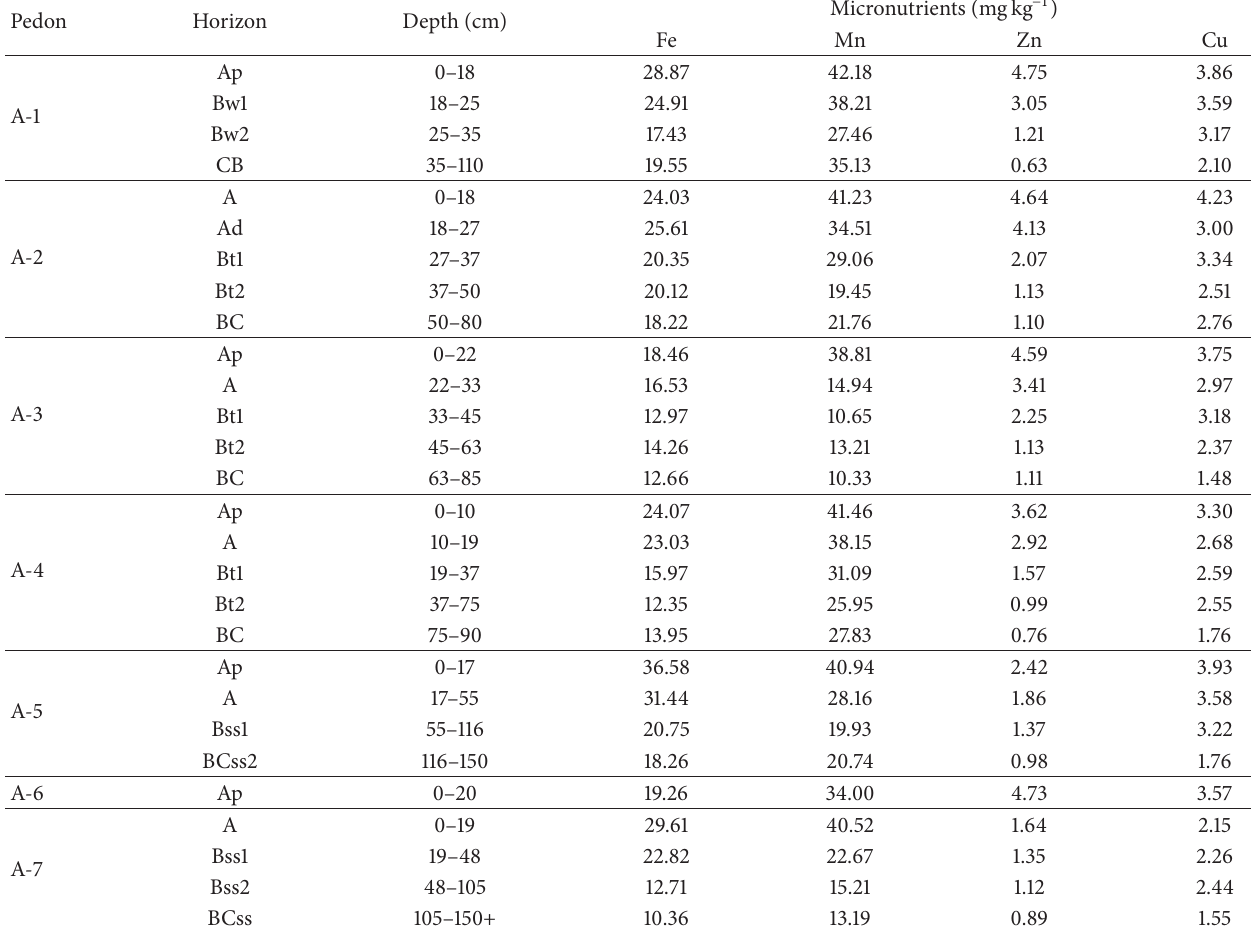
Table 9: Available micronutrient contents of the soil of Abobo area.